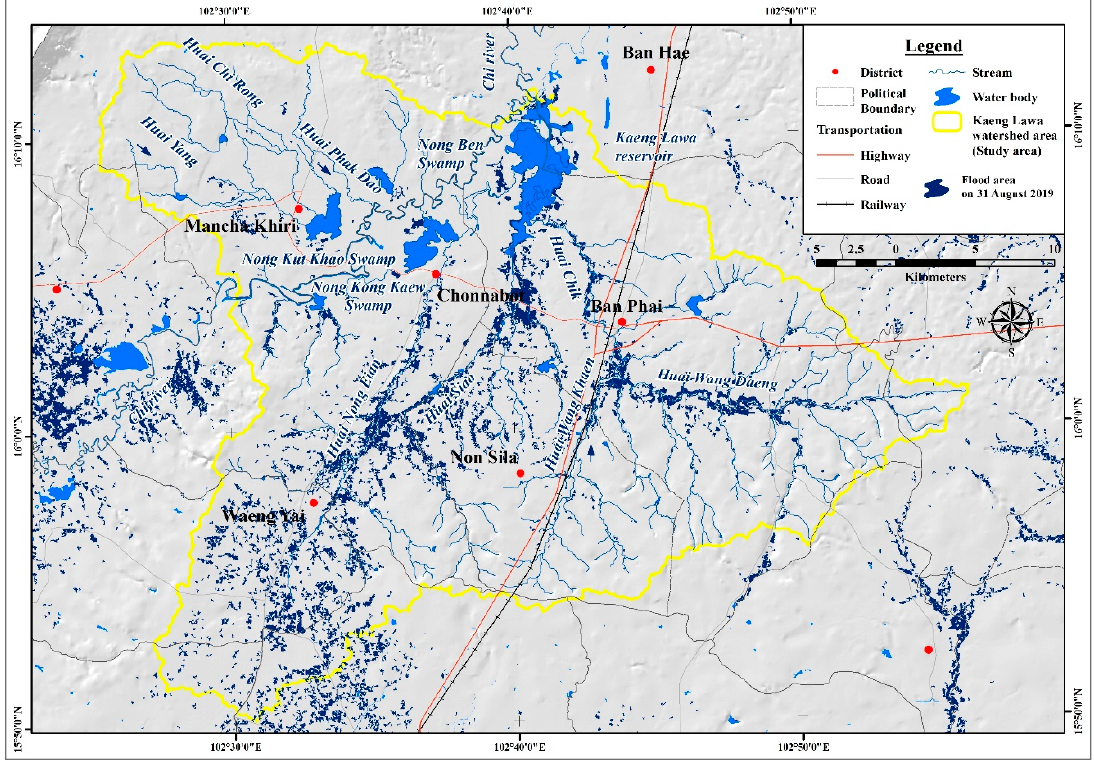
Figure 11. Flooding areas by the influence of Podul tropical storm during August 29–31, 2019.